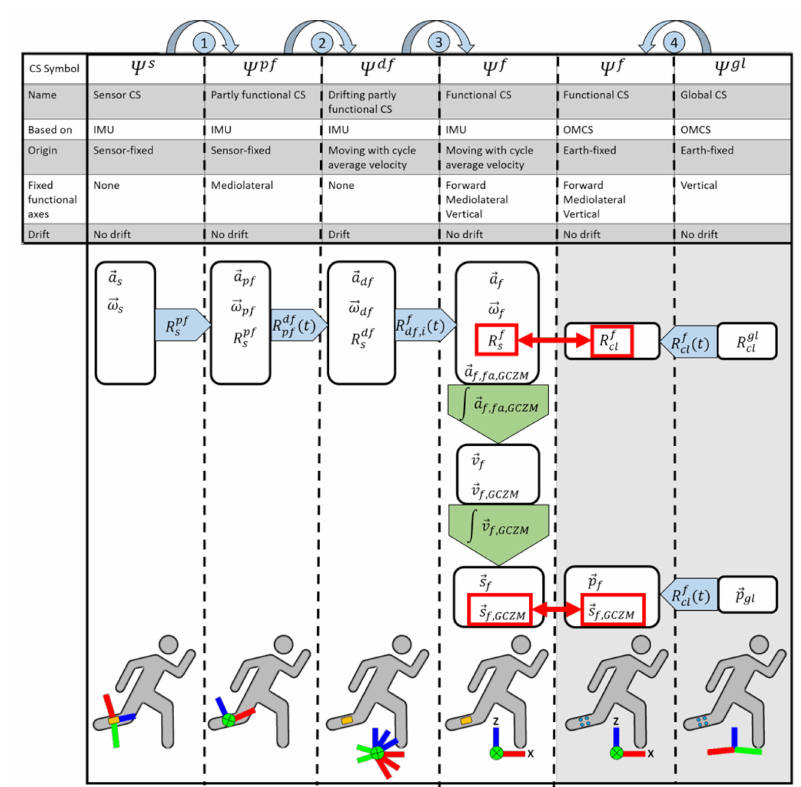
Figure 3. Summary of DFOD ( left four columns ) and the validation of DFOD ( right two columns ). Columns represent different coordinate systems (CS). For each CS some basic information is stated: symbol, name, measurement system on which the CS is based, origin, fixed functional axes (i.e., which axes have functional meaning), and the presence of drift. Available quantities in each CS are shown in white squares (all time-dependent), rotation matrices from one CS to another are shown in blue arrows, curved arrows at the top represent the different rotations which are referred to in the text, integrations over time are shown as green arrows. At the bottom of the figure, a schematic representation of the CS with respect to the lower leg of a runner is shown, orange boxes represent the IMU, and blue dots represent the cluster marker set. DFOD is validated against an OMCS based on the quantities in the red squares. Note that the CSs in grey (two right columns) are only used for validation of DFOD and are not a part of DFOD. IMU = inertial measurement unit; OMCS = optical motion capture system; GCZM = gait cycle zero mean (mean value over each gait cycle is subtracted → a CS = acceleration expressed in the CS in the subscript; from the gait cycle); CS = coordinate system; → → a f , fa , GCZM = free acceleration ( f a ) with ω CS = angular velocity expressed in the CS in the subscript; a gait cycle zero mean average ( GCZM ) expressed in the functional CS ( f ) ; R CS 2 = rotation matrix CS 1 → → → v = velocity; s = displacement; p = position, i = index of gait from CS 1 to CS 2;